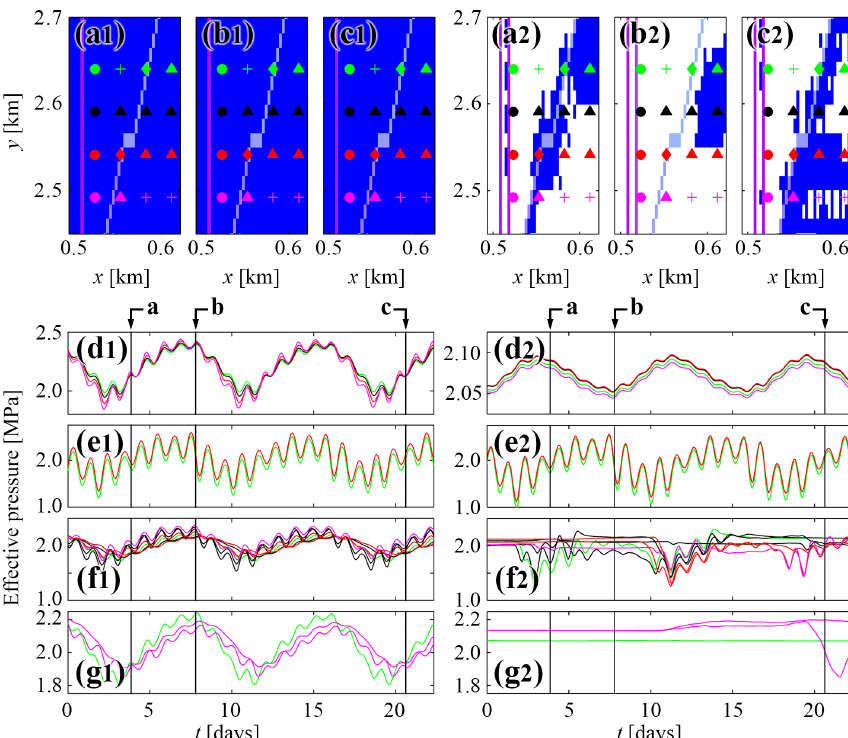
Figure 17. A synthetic borehole grid in the model with (right-hand column) and without a percolation cut-off (left-hand column). Panels (a–c) : enlargements of the inset box in Fig. 16d2, h2 at times t = 3 . 9 (a) , 7.8 (b) and 20.6 (c) days. Superimposed on the blue connectivity map is S R conduit size, plotted using the same colour scheme as indicated by the colour bar in panels (a) and (e) in Fig. 16. Also shown are the locations of 16 synthetic boreholes, colour-coded by row (d–g) . Effective pressure time series from the boreholes, grouped according to borehole symbols: circles (d) , diamonds (e) , triangles (f) , crosses (g) . Each time series is colour-coded by